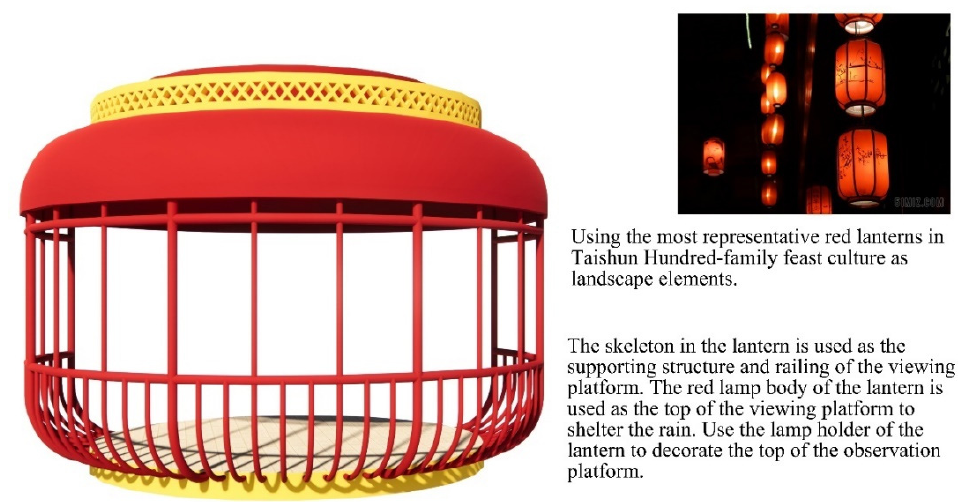
Figure 16. Lantern viewing platform.